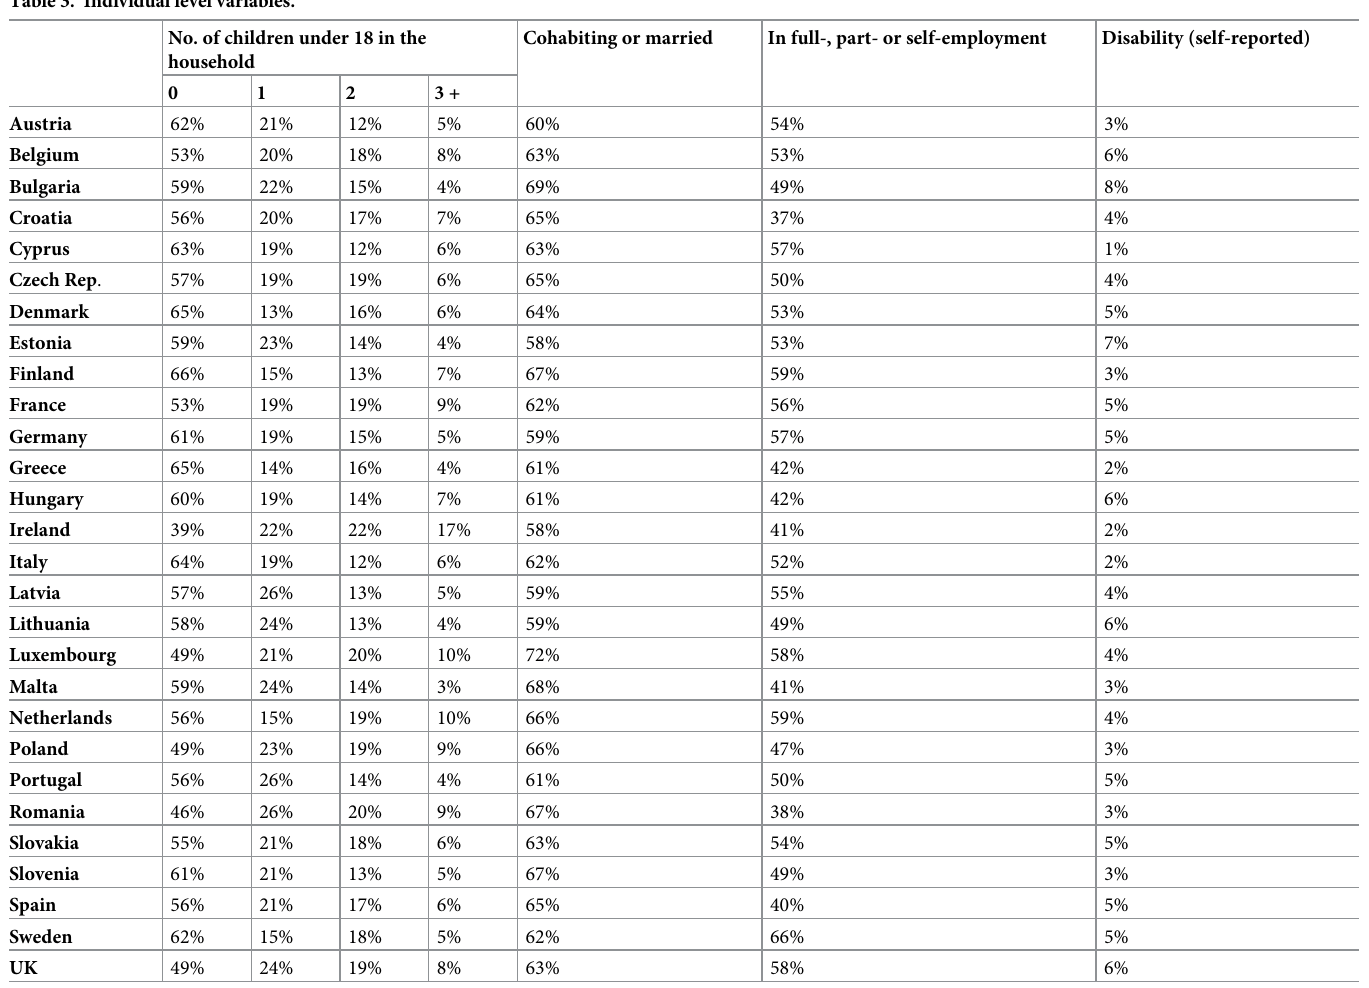
Table 3. Individual level